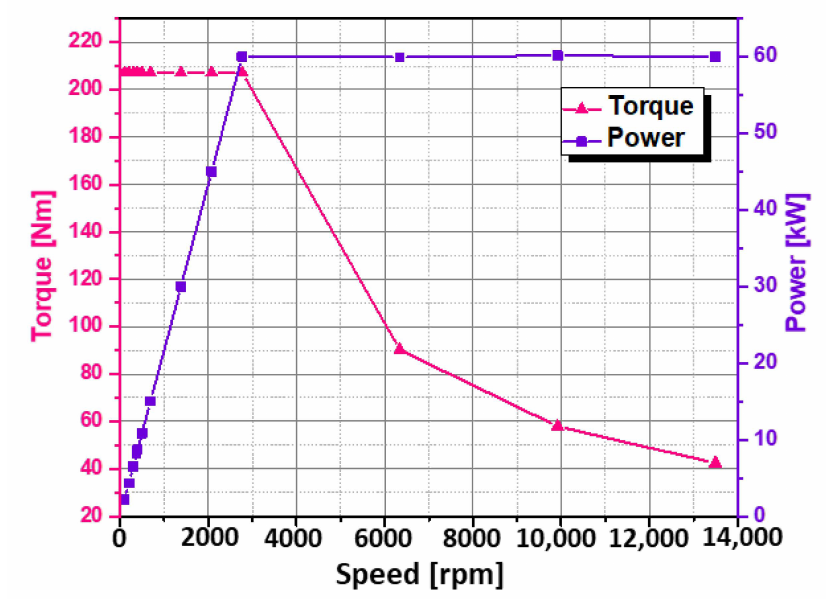
Figure 14. Wide speed range characteristics of optimal WRSM